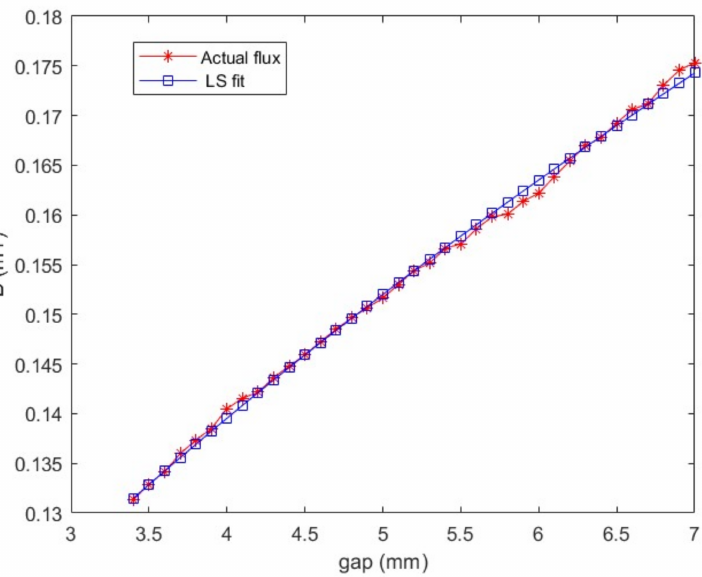
Figure 9. Comparison of the actual magnetic flux and the magnetic flux estimated by the final